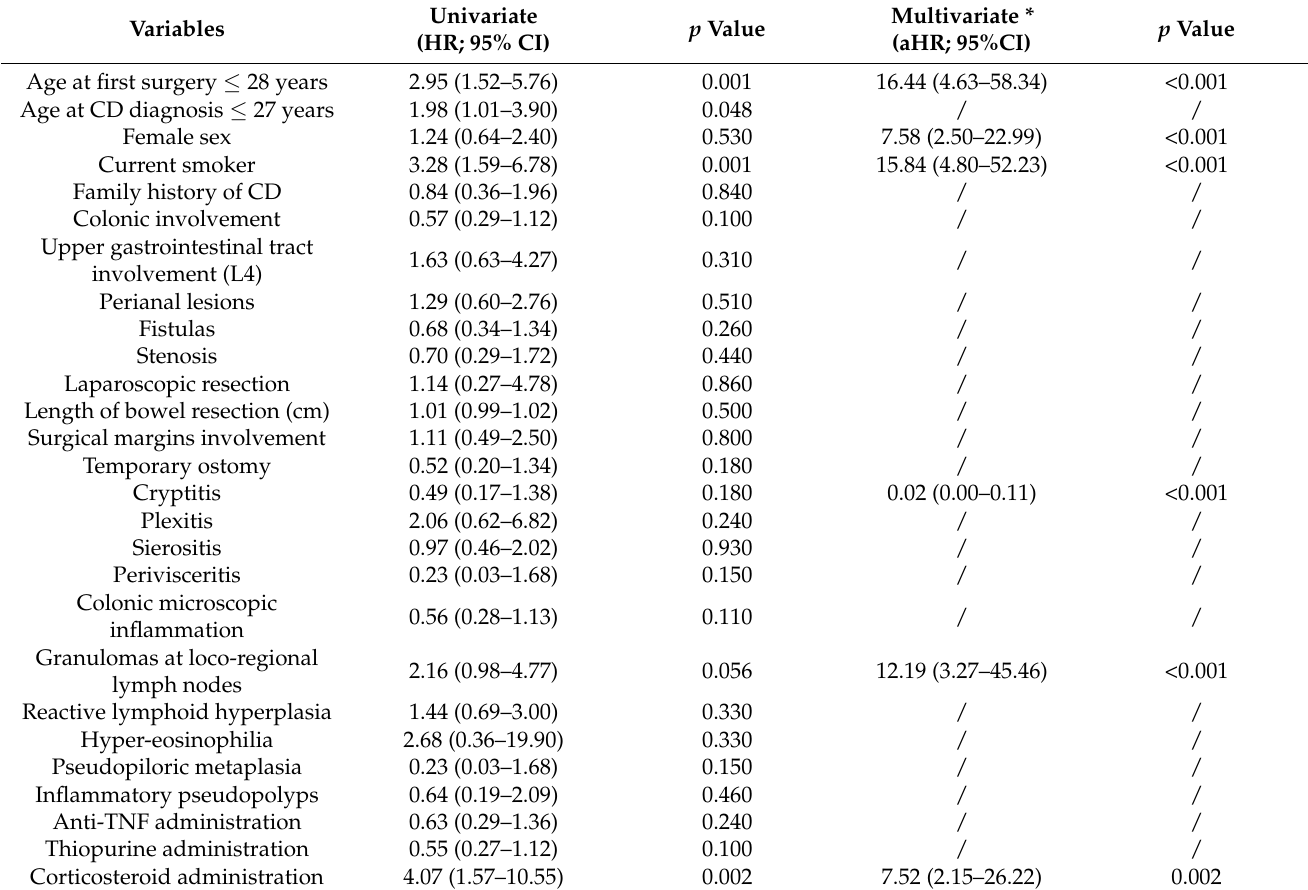
Table 2. Univariate and multivariate Cox regression analysis of factors associated to surgi- cal